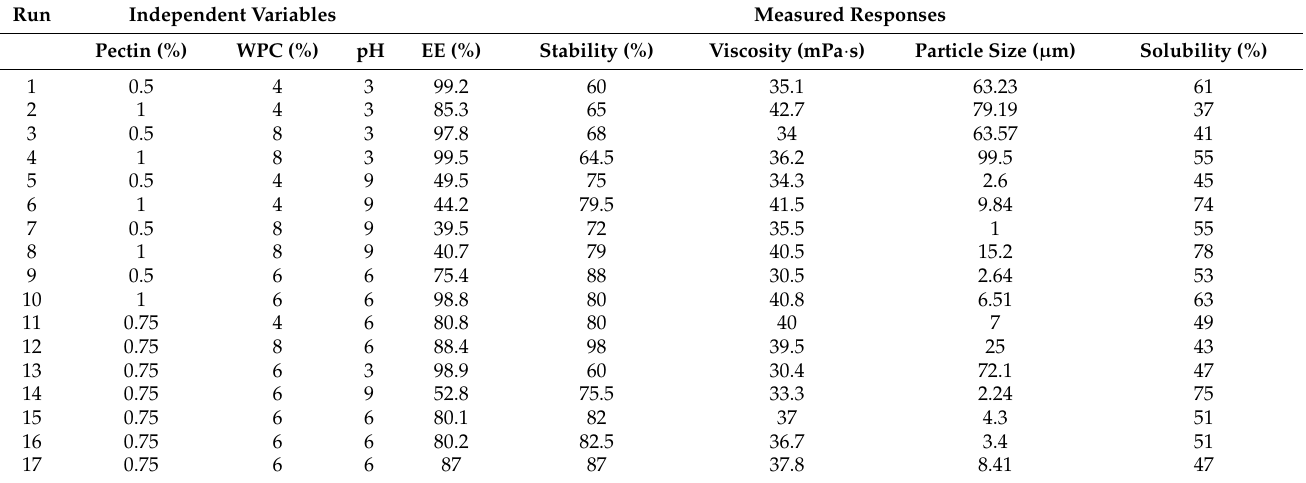
Table 3. Central composite rotatable design with experimental values of responses based on indepen- dent